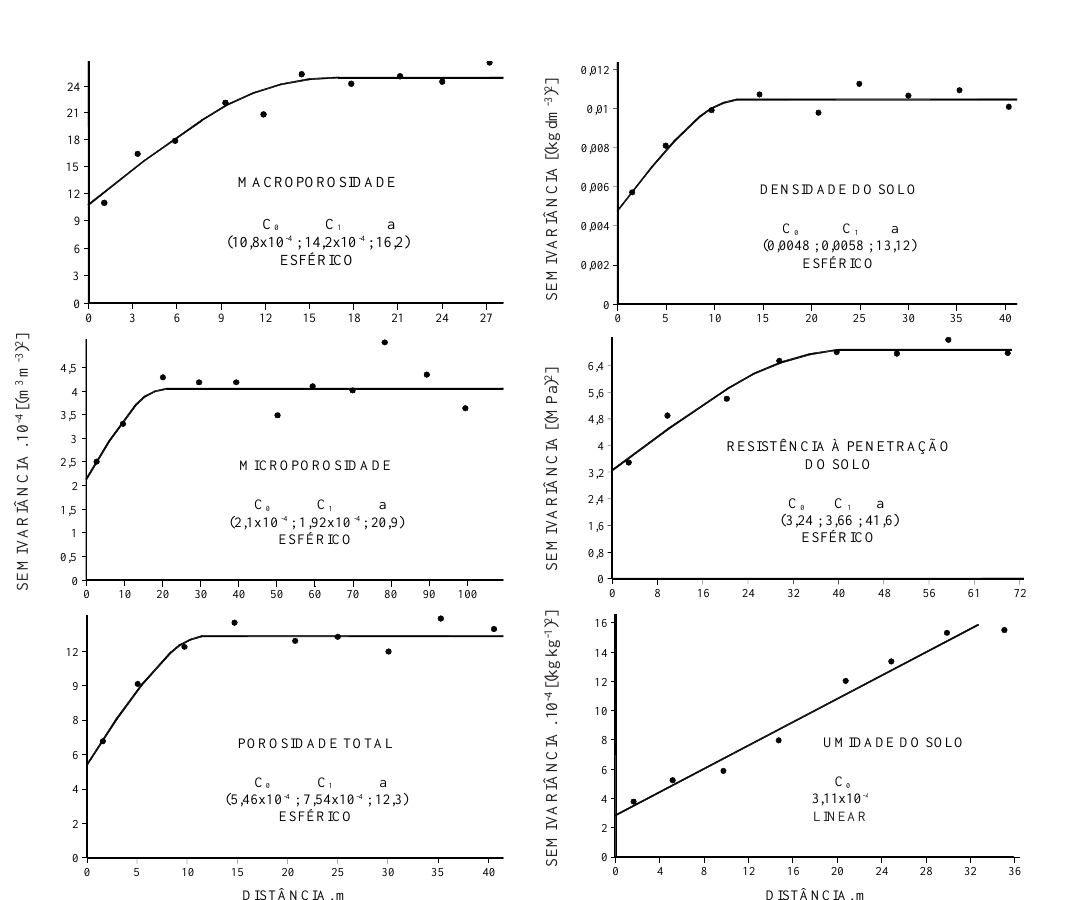
Figura 1. Semivariogramas dos atributos: macroporosidade, microporosidade, porosidade total, densidade do solo, resistência à penetração do solo e umidade do solo na profundidade de 0,00- 0,05 m, em um Latossolo Vermelho